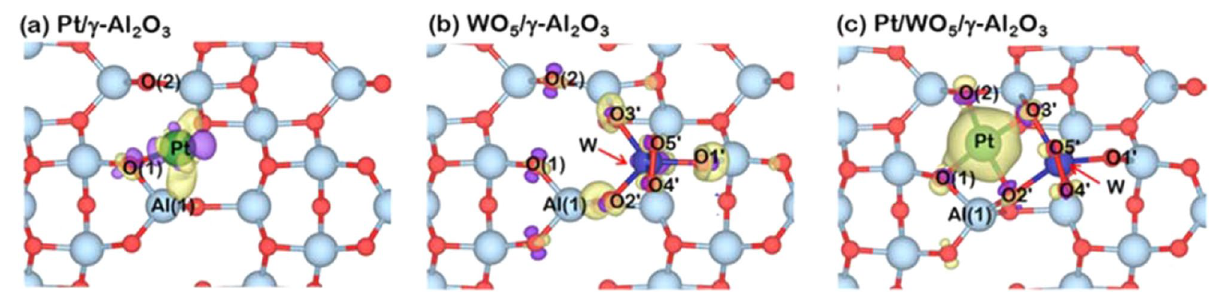
Figure 6. Charge density differences of ( a ) Pt atom adsorption on γ-Al 2 O 3 surface, ( b ) WO 5 molecule adsorption on γ-Al 2 O 3 surface, and ( c ) Pt atom adsorption on WO 5 /γ-Al 2 O 3 surface presented with isovalue of ± 0.015 e Å −3 . The electron accumulation and depletion are represented by yellow and violet regions, respectively. Note that the atomic radius of each atom is modeled to its isolated atomic